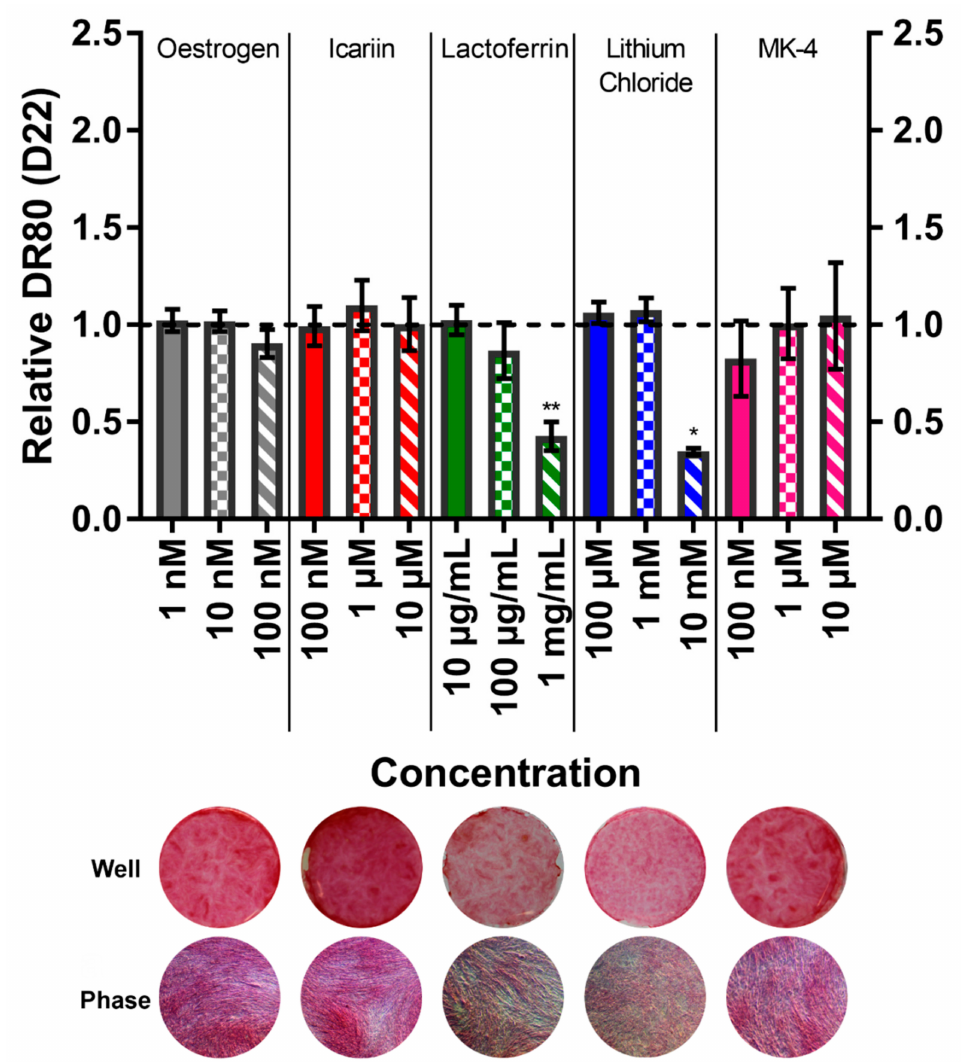
Figure 7. ( Top ) The e ff ect of each compound and concentration on the collagen deposition at day 22, normalised to their respective vehicle control (horizontal dashed line). Lactoferrin (1 mg / mL) and lithium chloride (10 mM) significantly diminished the collagen deposition (p < 0.01 & p < 0.05, respectively). No other condition significantly deviated from the vehicle control. (n = 8). ( Bottom ) Representative whole well images (diameter ~15 mm) and high magnification (40 × ) phase contrast images (diameter 200 µ m) of DR80 staining of each compound at the highest concentration